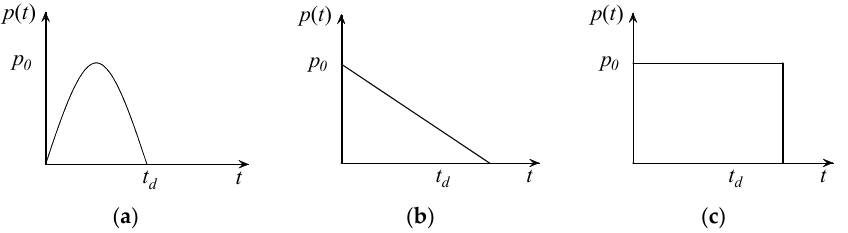
Figure 3. Three types of idealized shock excitation: ( a ) Half-cycle sine; ( b ) Initial peak triangular; ( c ) Rectangular.